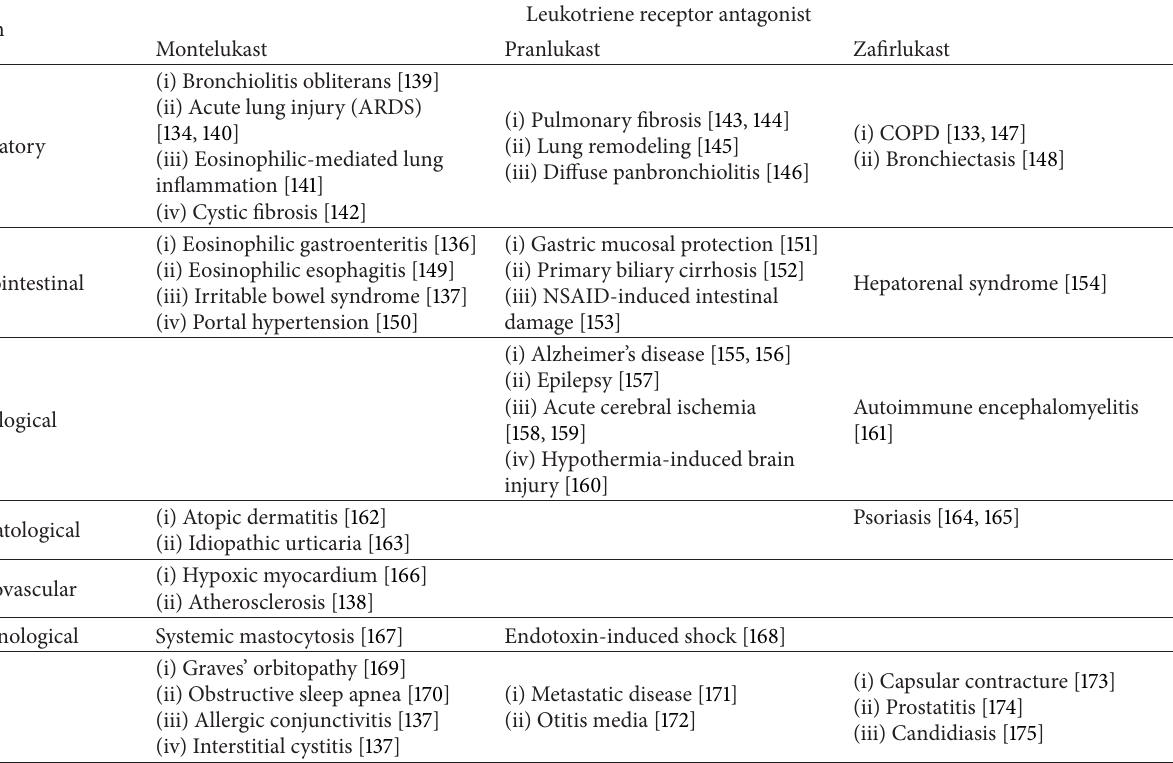
Table 3: Pathological conditions involving multiple organ systems which may be amenable to therapy with montelukast, pranlukast, or